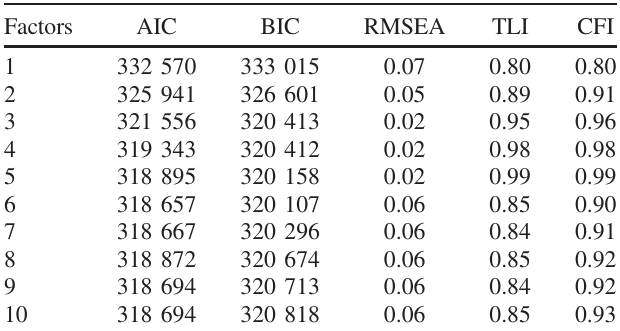
TABLE I. MIRT fit statistics for an exploratory factor analysis of the